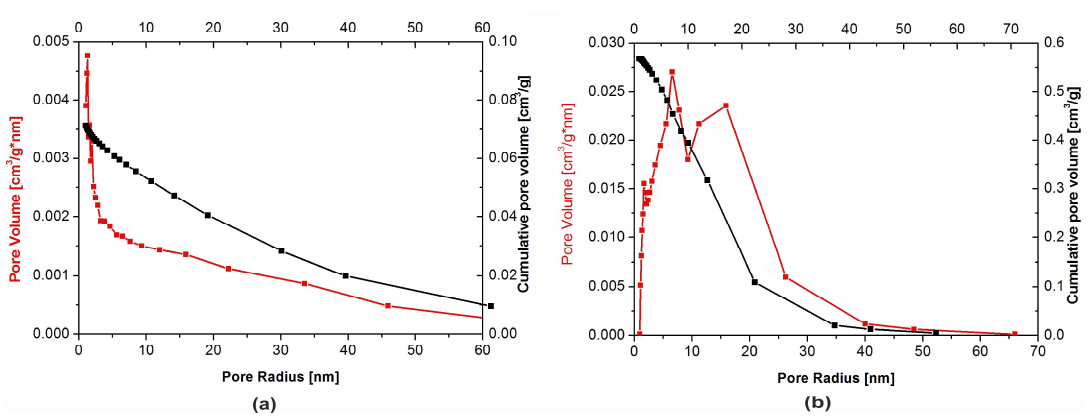
Figure 5. Pore size distribution for: ( a ) Nanosize particles and ( b ) microsize particles powders.